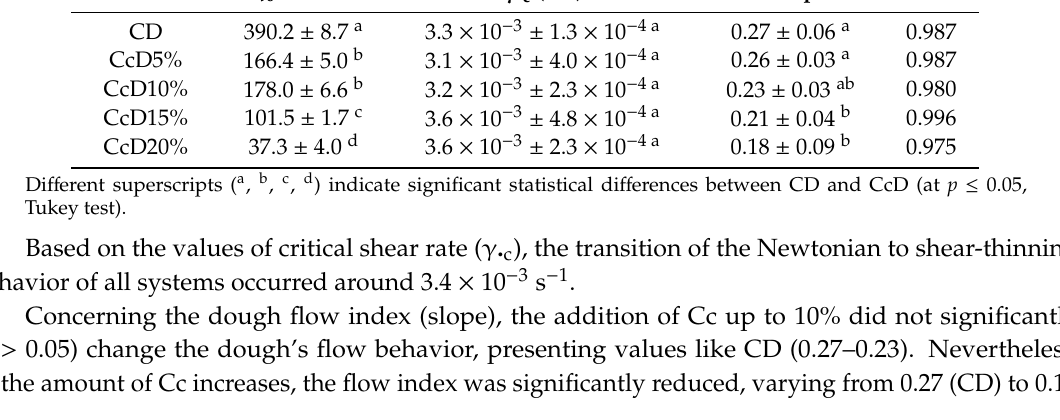
Table 3. Fitted rheology parameters estimated for control dough (CD) and curd cheese doughs (CcD5% up to CcD20%), by applying Carreau Model .